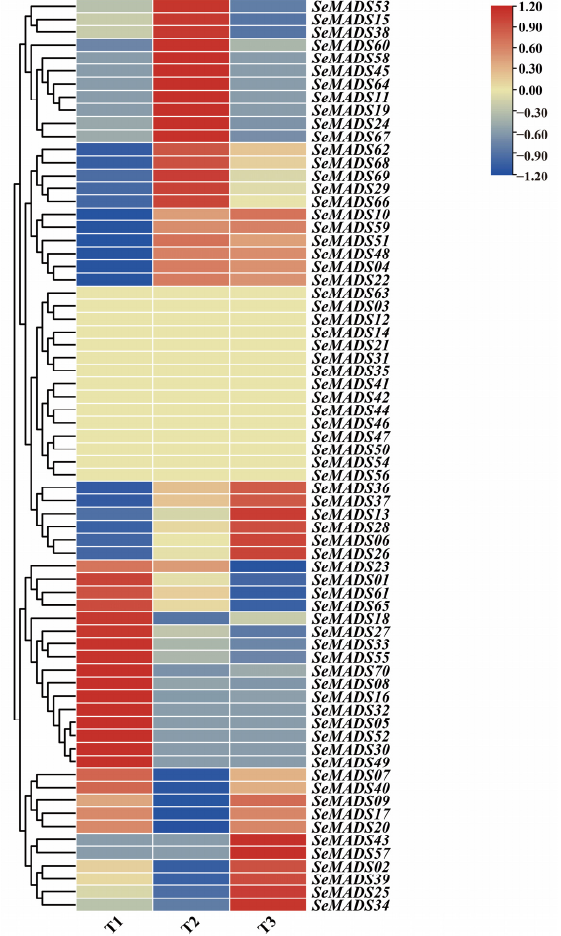
Figure 8. Expression of SeMADS genes in di ff erent developmental stages of root tuber in ‘Tuershao’. The heatmap represented the log2 (FPKM+1) value of SeMADS genes. T1: early stage, T2: middle stage, T3: mature stage.